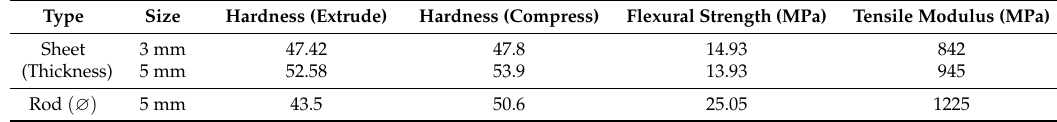
Table 2. Mechanical properties of the MCF/PP